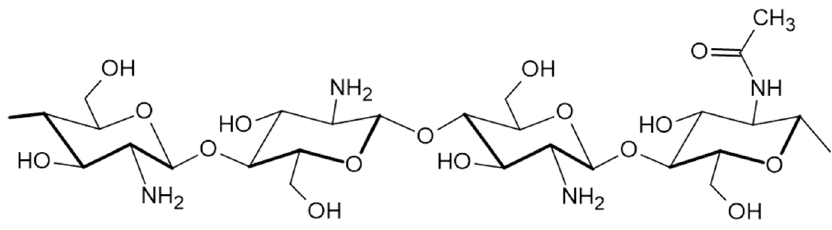
Figure 1. Scheme presenting the chitosan’ structure.